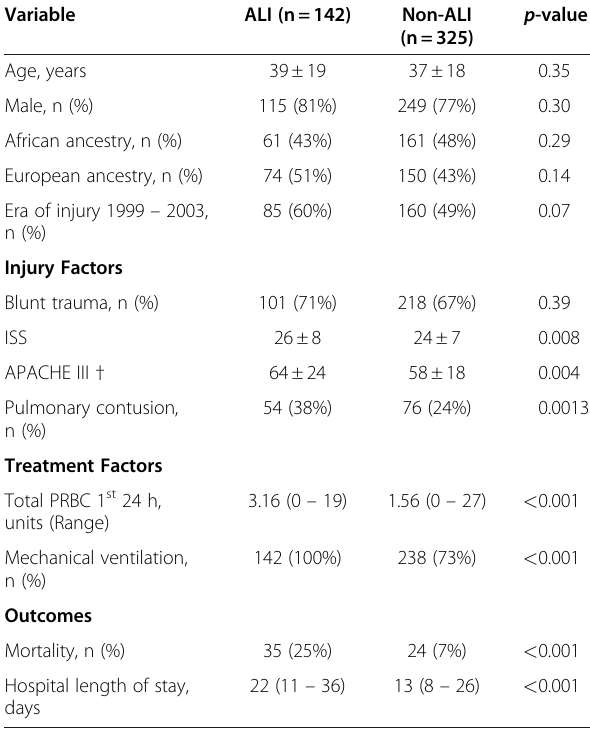
Table 1 Study population and clinical